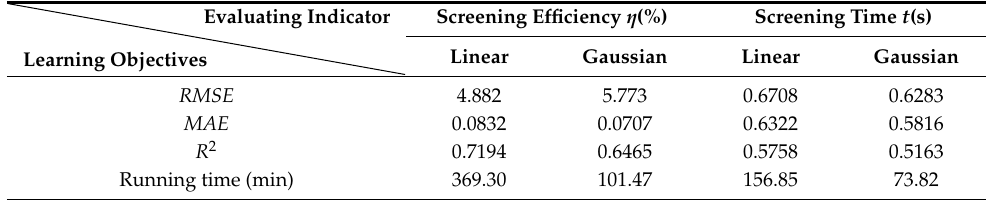
Table 7. Performance of the GWO-SVR screening model under two kernel